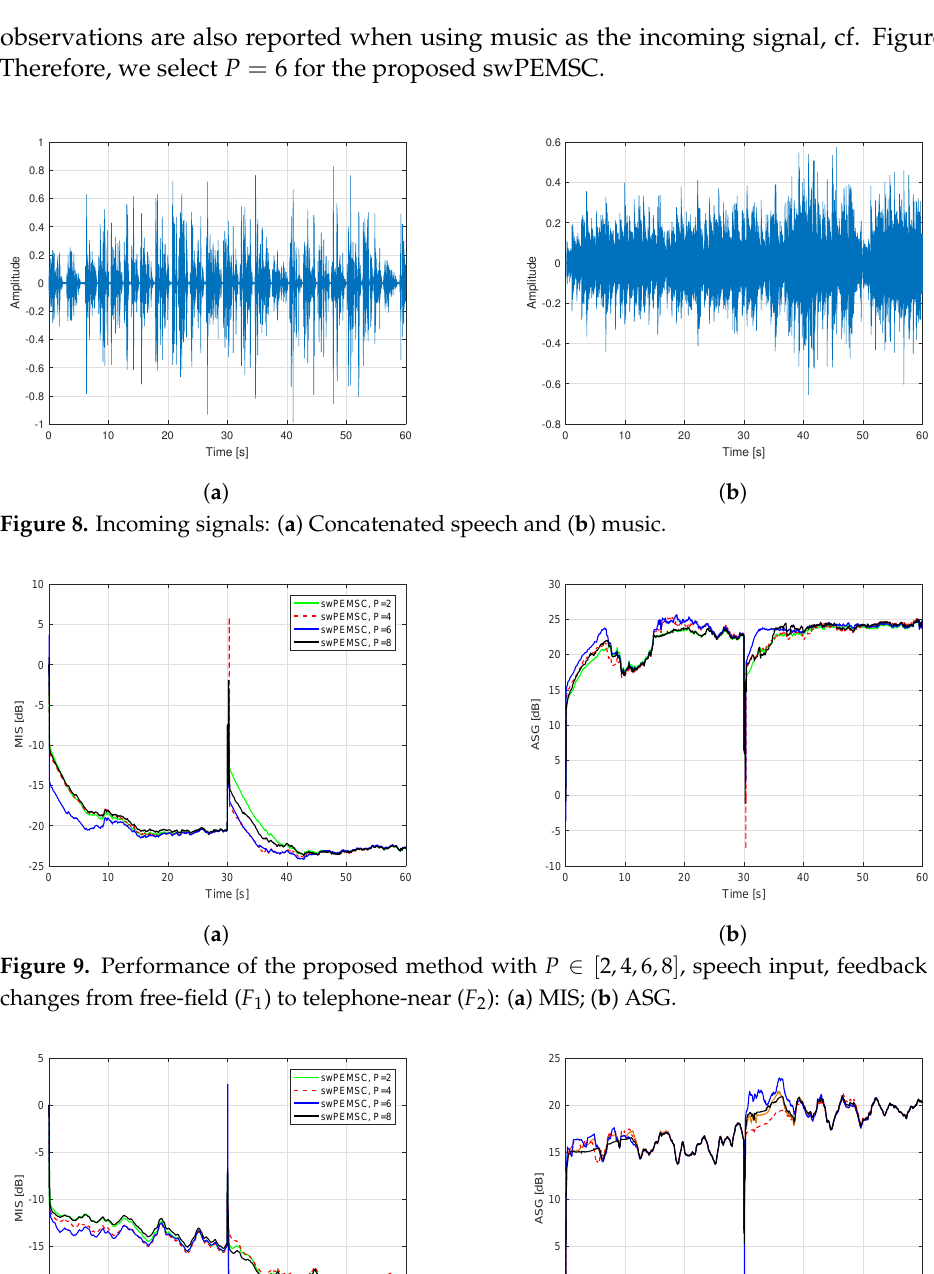
observations are also reported when using music as the incoming signal, cf. Figure 10. Therefore, we select P = 6 for the proposed swPEMSC.